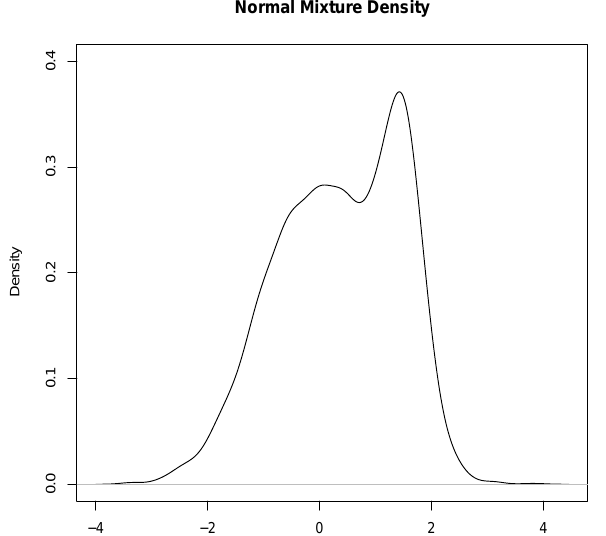
Figure 1. This figure illustrates a Mixture distribution combining two Gaussian distributions on two different parts of the underlying dataset. The illustration has been obtained using the R pack- age